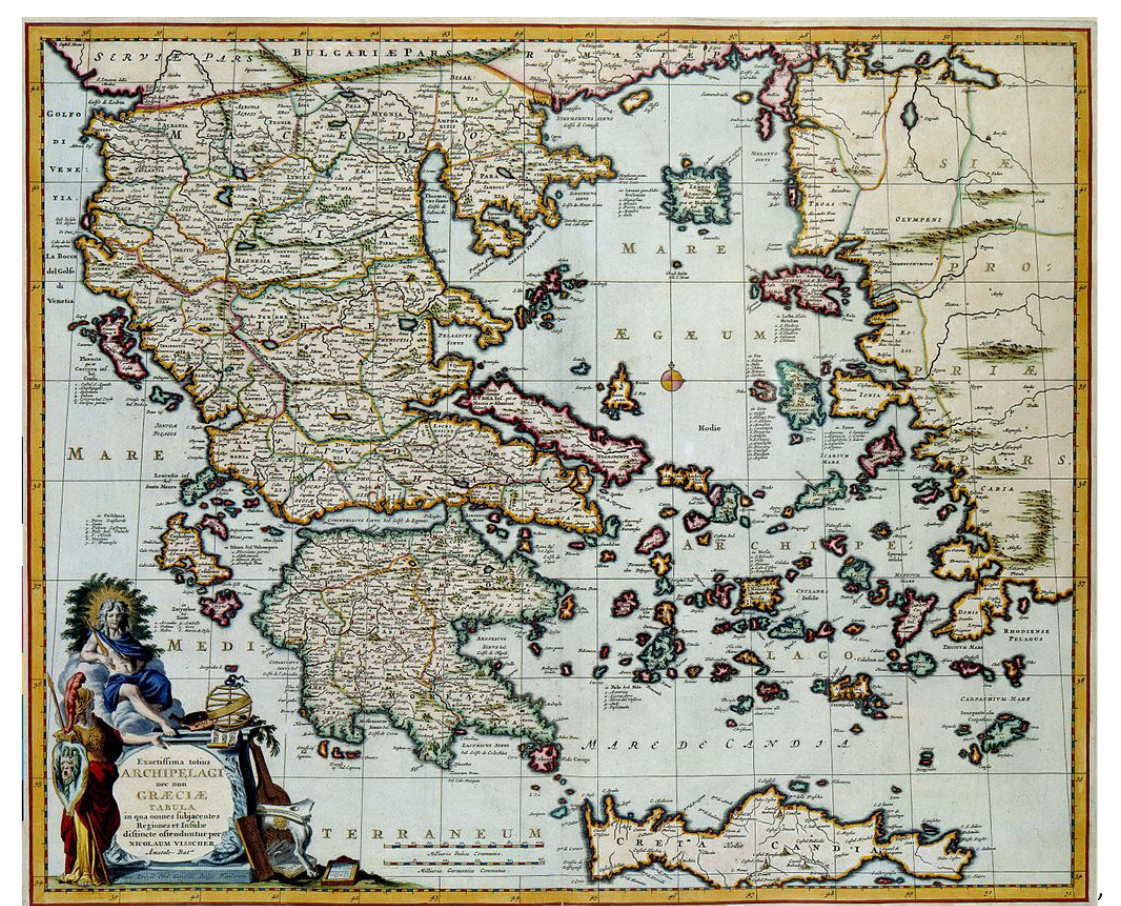
Figure 1. A map of the Aegean, by Nicolaum Visscher (1649 − 1702), published around 1681, illustrating a complex island region in which it is challenging to decide on archipelago or meta-archipelago membership from a biological perspective. Sourced from Wikimedia Commons, wherein it is stated that this is an image from the digital and/or physical collections of the Koninklijke Bibliotheek, the Dutch National